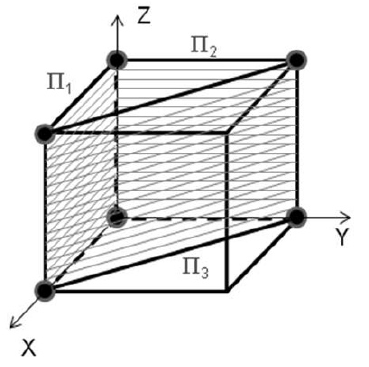
Algorithm 1. Basic method for 3D coordinates reconstruction and Π 1 Π 2 facilitates calculation of the third plane Step 1 Calculation of the projections of points p C